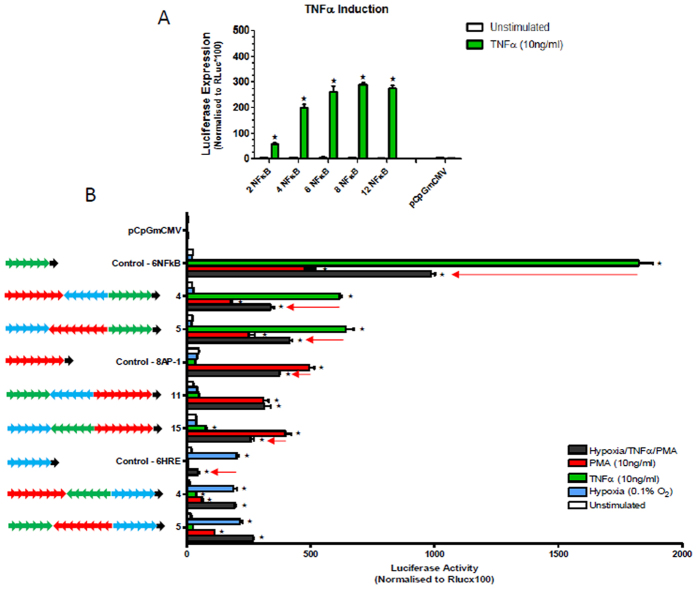
Optimised TFBS number and responsiveness of cluster promoters.The influence of increasing the number of NF-κB sites on promoter responsiveness to TNFα was assessed in transfected 293T cells as illustrated in A (white bars unstimulated, green bars TNFα stimulated). Cluster composite promoters were generated with each type of cluster (NF-κB, AP-1 and HRE) in the proximal position. Basal activity and stimulated activity of these promoters is shown in (B). Data in (A) was analysed by 2 way ANOVA to take into account the effect of the change in number of NFkB clusters and the effect of stimulation upon the promoters. This analysis revealed that both factors had significant effects on promoter activity. A post-hoc Šidak test was then performed to compare the stimulated and non-stimulated activity of each promoter and significant differences of p < 0.05 are indicated by ★. The responsiveness of each individual cluster promoter in (B) to stimulation was analysed by 1 way ANOVA. A post-hoc Šidak test was then performed to determine the level of significance of mean values above the unstimulated promoter activity. Where the difference from baseline promoter activity was significantly (p < 0.05) different this is indicated by ★. The post-hoc Šidak test also revealed when combined stimulation resulted in a significantly (p < 0.05) lower promoter activation than achieved with the optimal individual stimulation and is illustrated by red arrows.